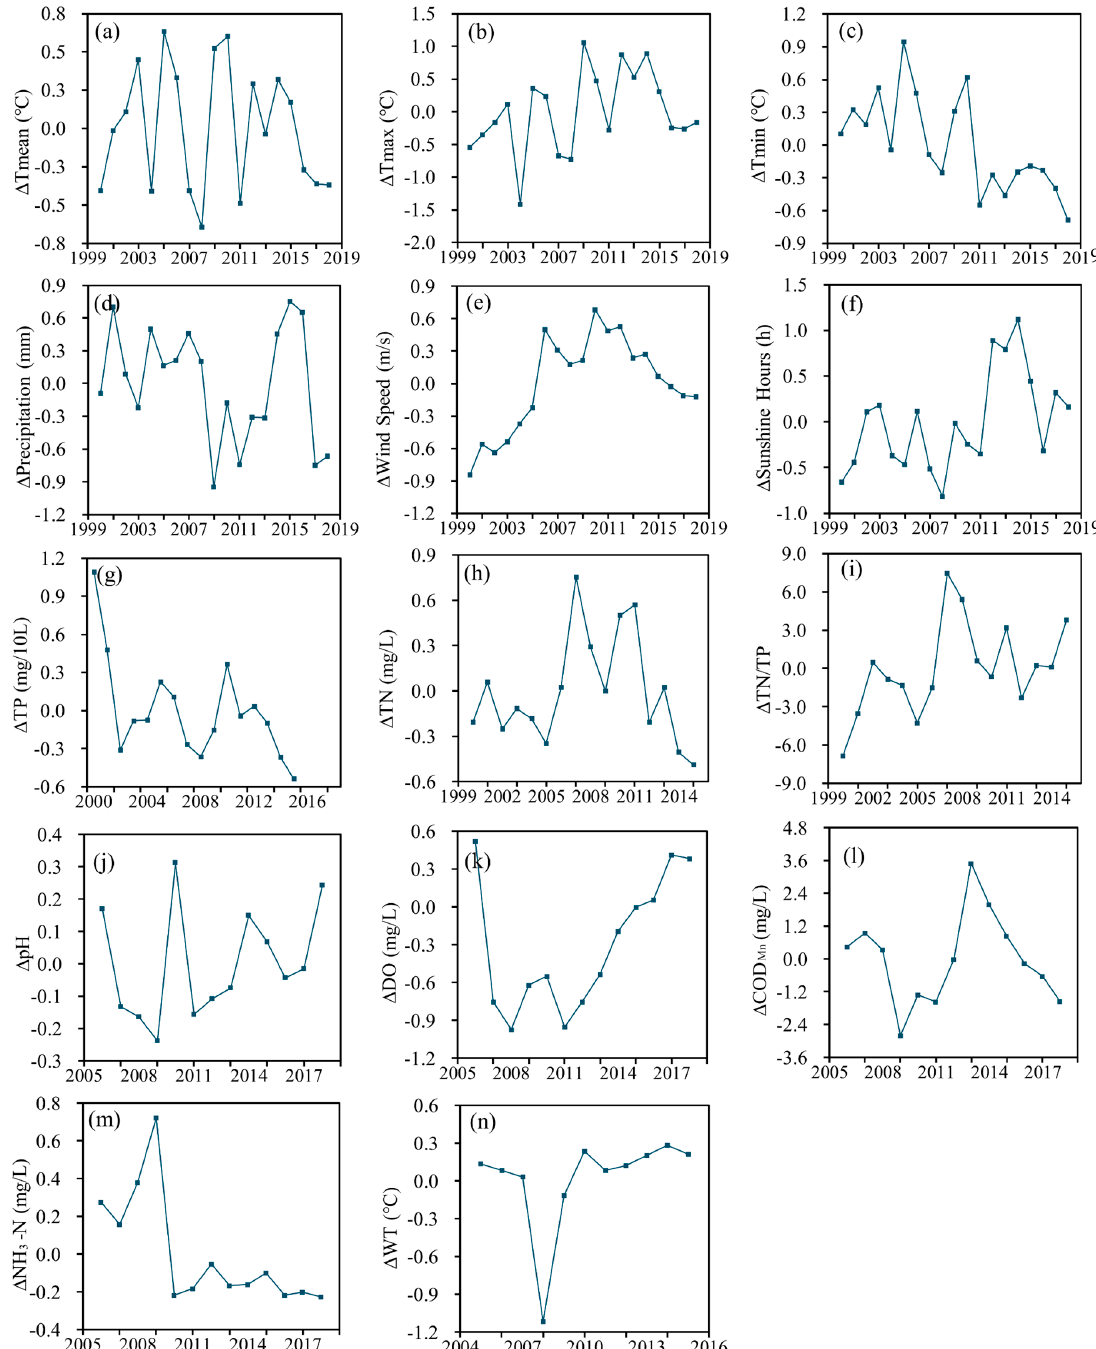
Figure 16. Trends in annual average anomalies of ( a ) mean temperature; ( b ) maximum temperature; ( c ) minimum temperature; ( d ) precipitation; ( e ) wind speed; ( f ) sunshine hours; ( g ) TP; ( h ) TN; ( i ) TN/TP; ( j ) pH; ( k ) DO; ( l ) COD Mn ; ( m ) NH 3 -N; and ( n ) WT during 2000–2018 in Lake Dianchi.